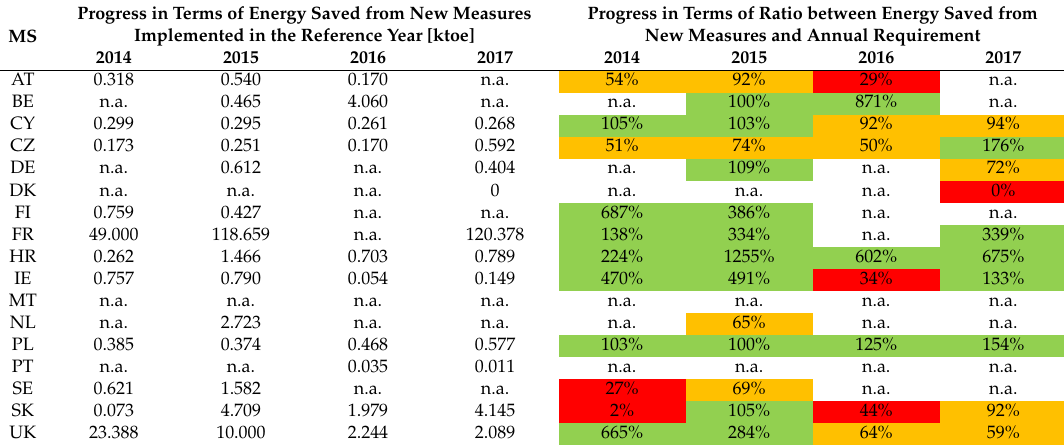
Table 6. Implementation progress of Article 5 requirement for Member States which chose the alternative approach (Art. 5(6)). Data are currently under